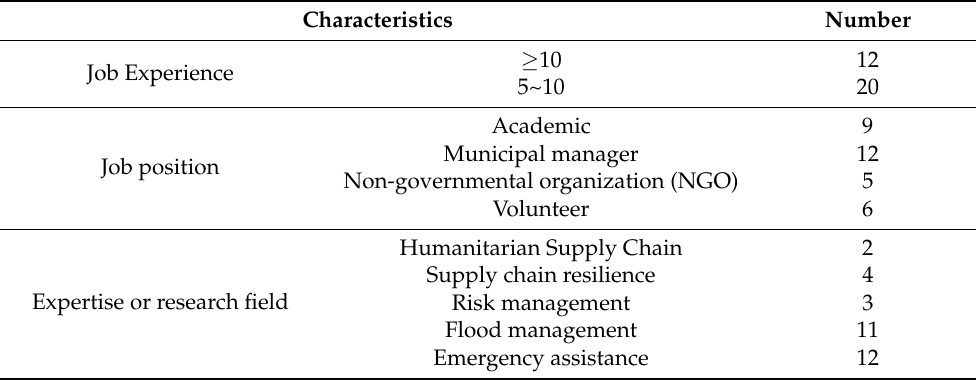
Table 3. Expert panel characteristics.